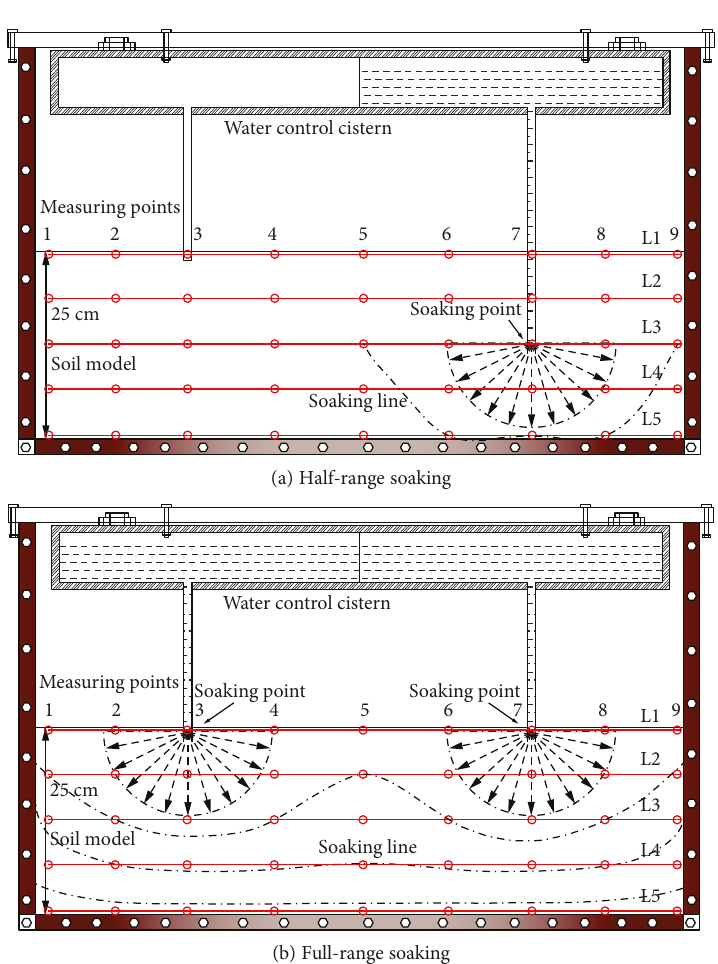
Figure 2: Design scheme of soaking